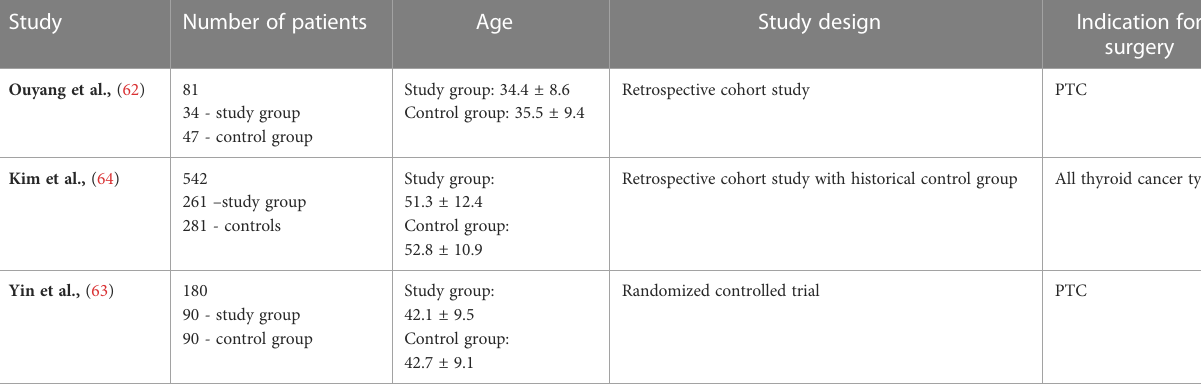
TABLE 1 Basic information about the studies on fl uorescence imaging in CLND for thyroid